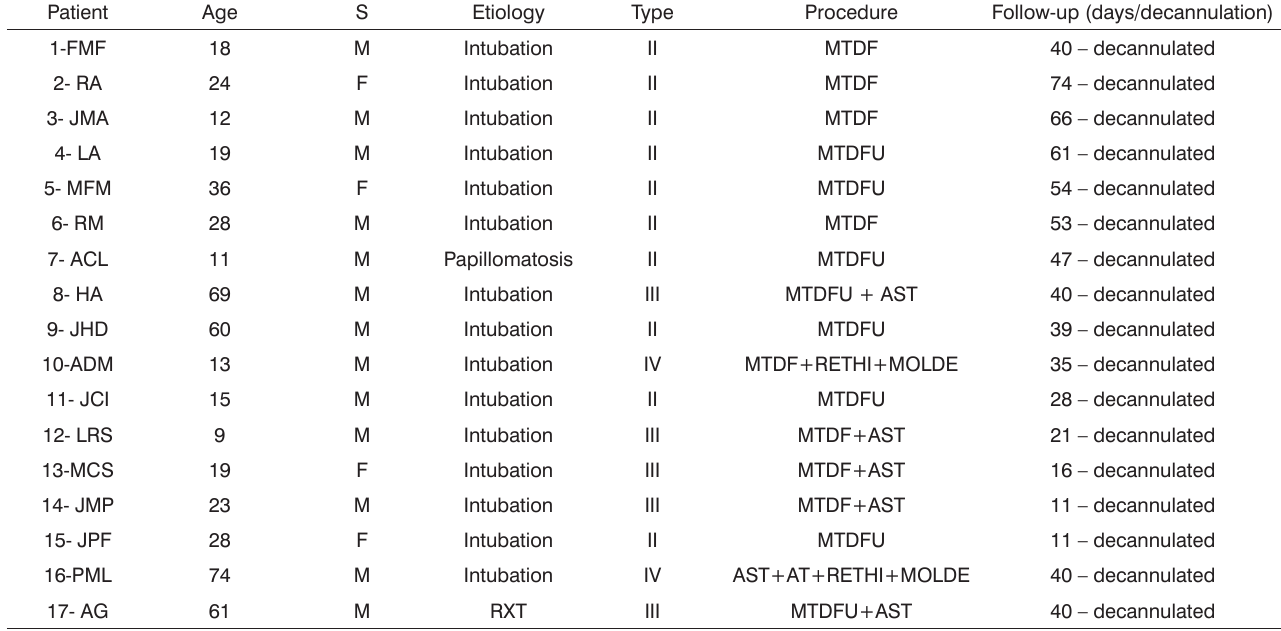
Table 2. Posterior Glottic Stenosis – Patient Data.